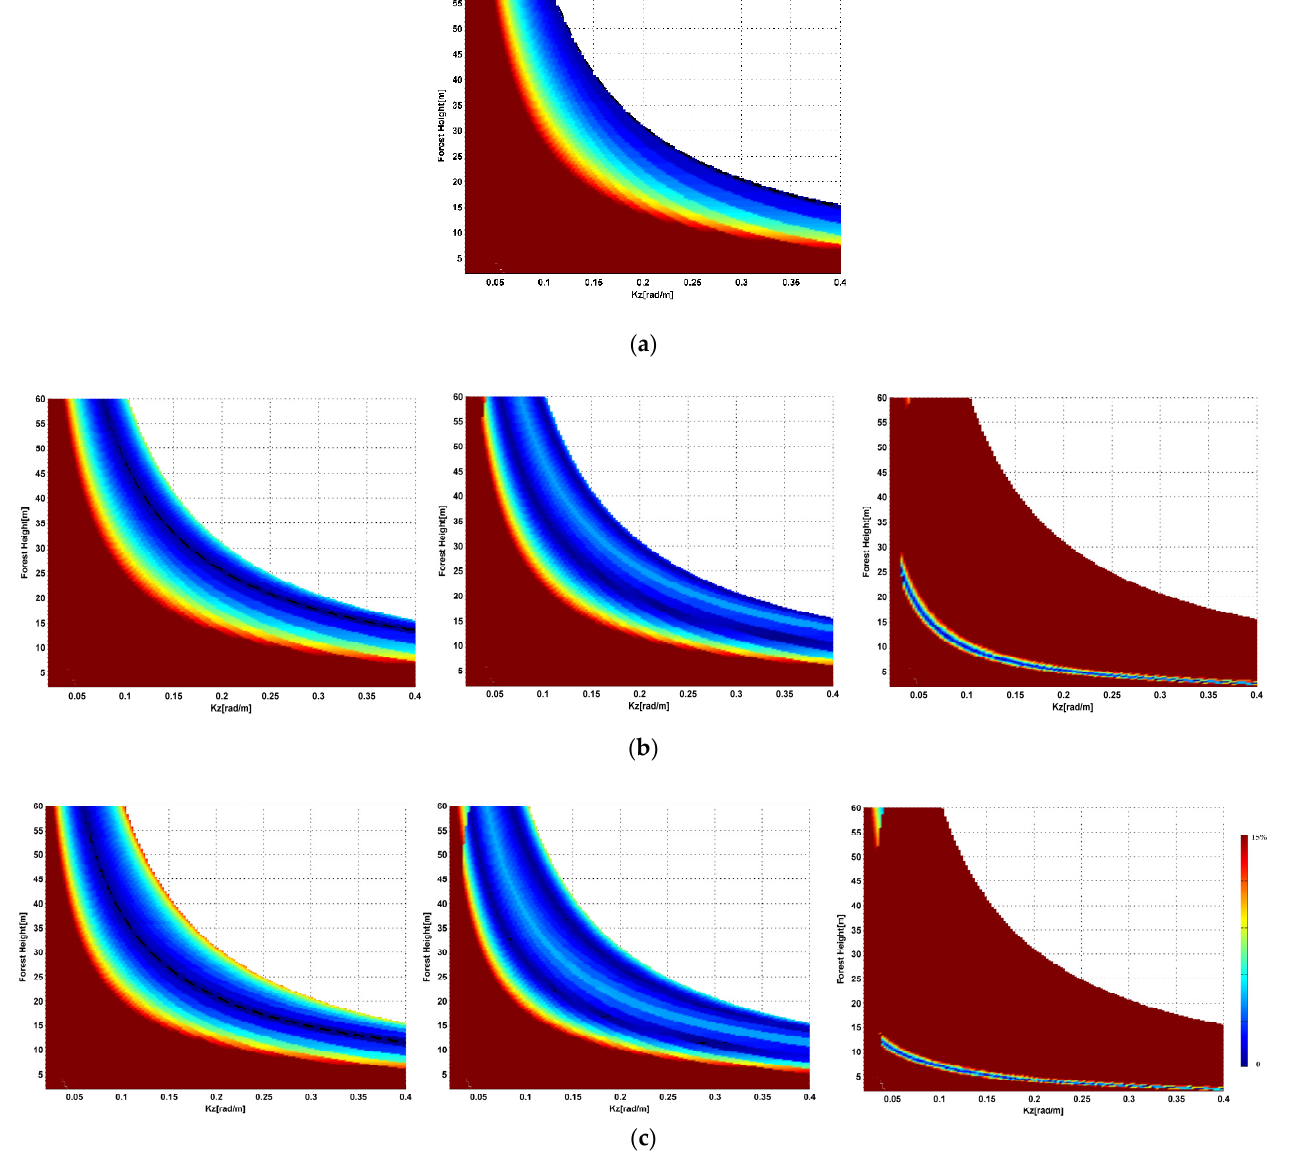
Figure 12. When the time decorrelation was 0.8, and extinction coefficient was fixed at 0, 0.1, 0.5 dB/m, respectively, the forest height relative error changed with the forest height and vertical wavenumber k z . ( a ) σ = 0 dB/m; ( b ) σ = 0.1 dB/m left: ε · L w = 0 middle: ε · L w = 0.04 right: ε · L w = 0.5; ( c ) σ = 0.5 dB/m left: ε · L w = 0 middle: ε · L w = 0.04 right: ε · L w = s s s s